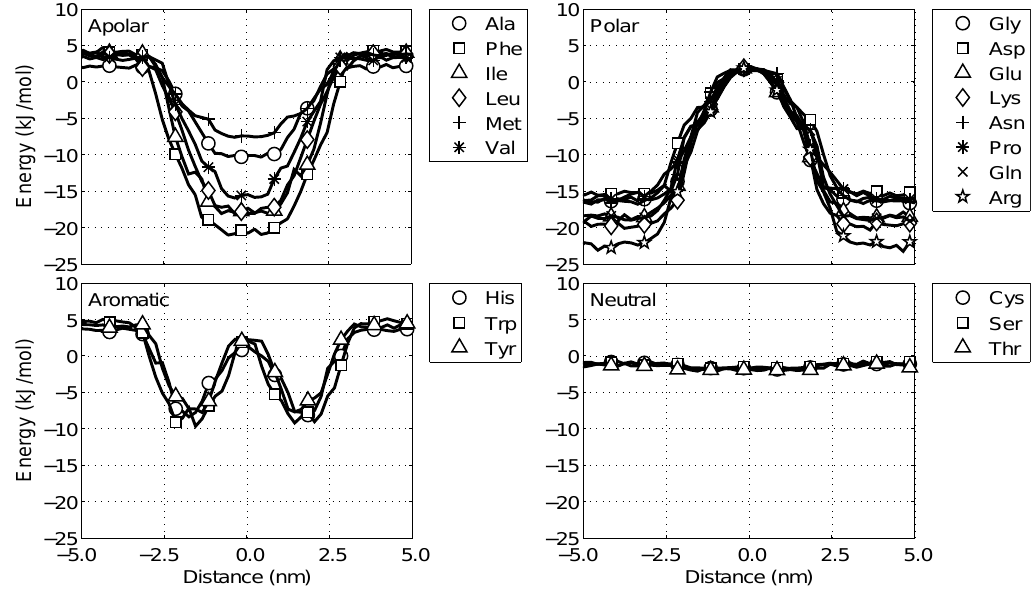
Non-bonded interaction energy between the CG protein particles and